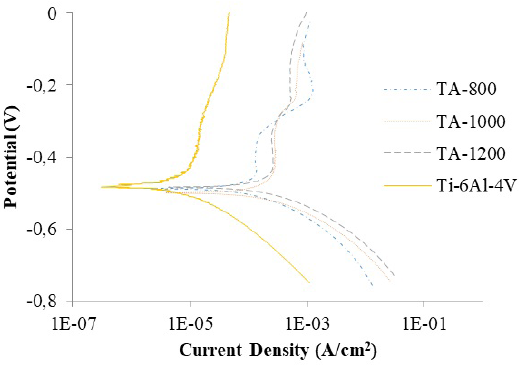
Figure 7. Polarization